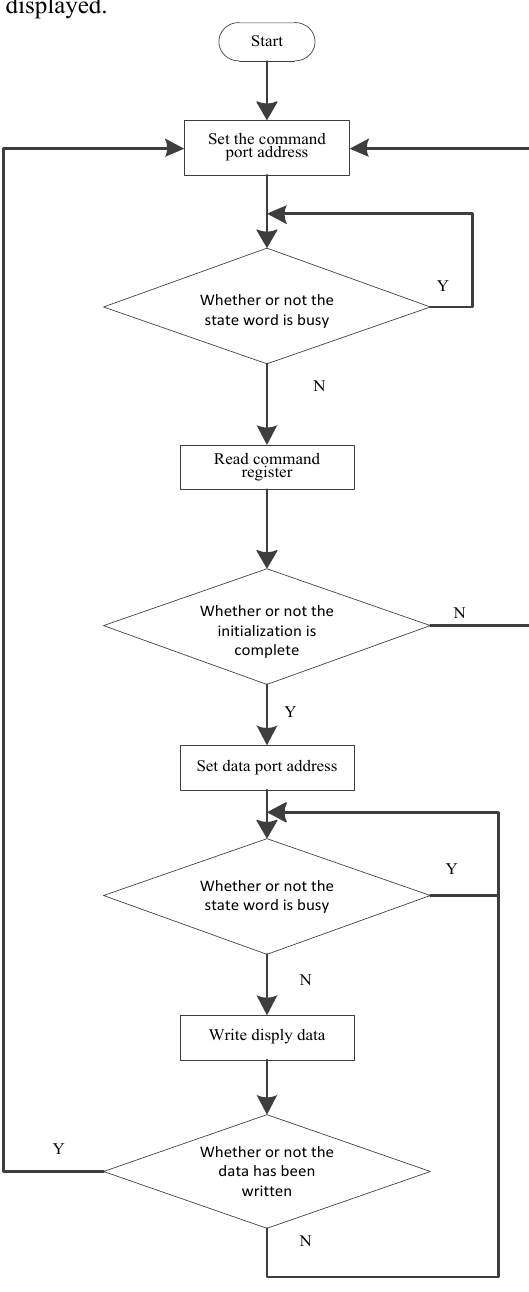
Fig. 9. The flowchart of the display